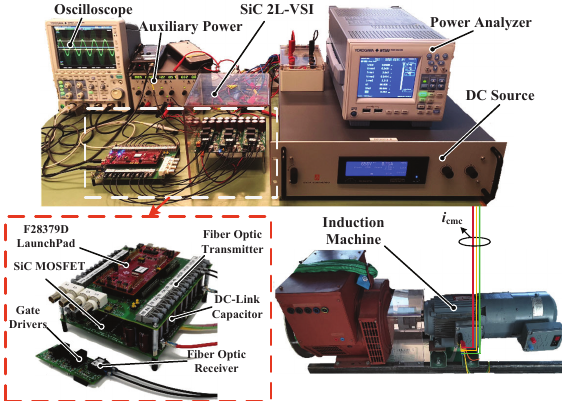
Figure 8. The experimental